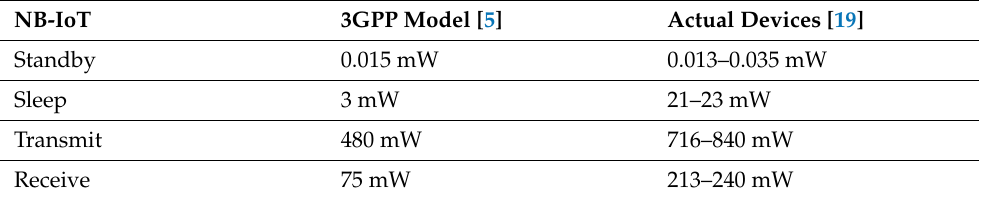
Table 1. Communication Power consumption for NB-IoT model and devices ( E Communication ).